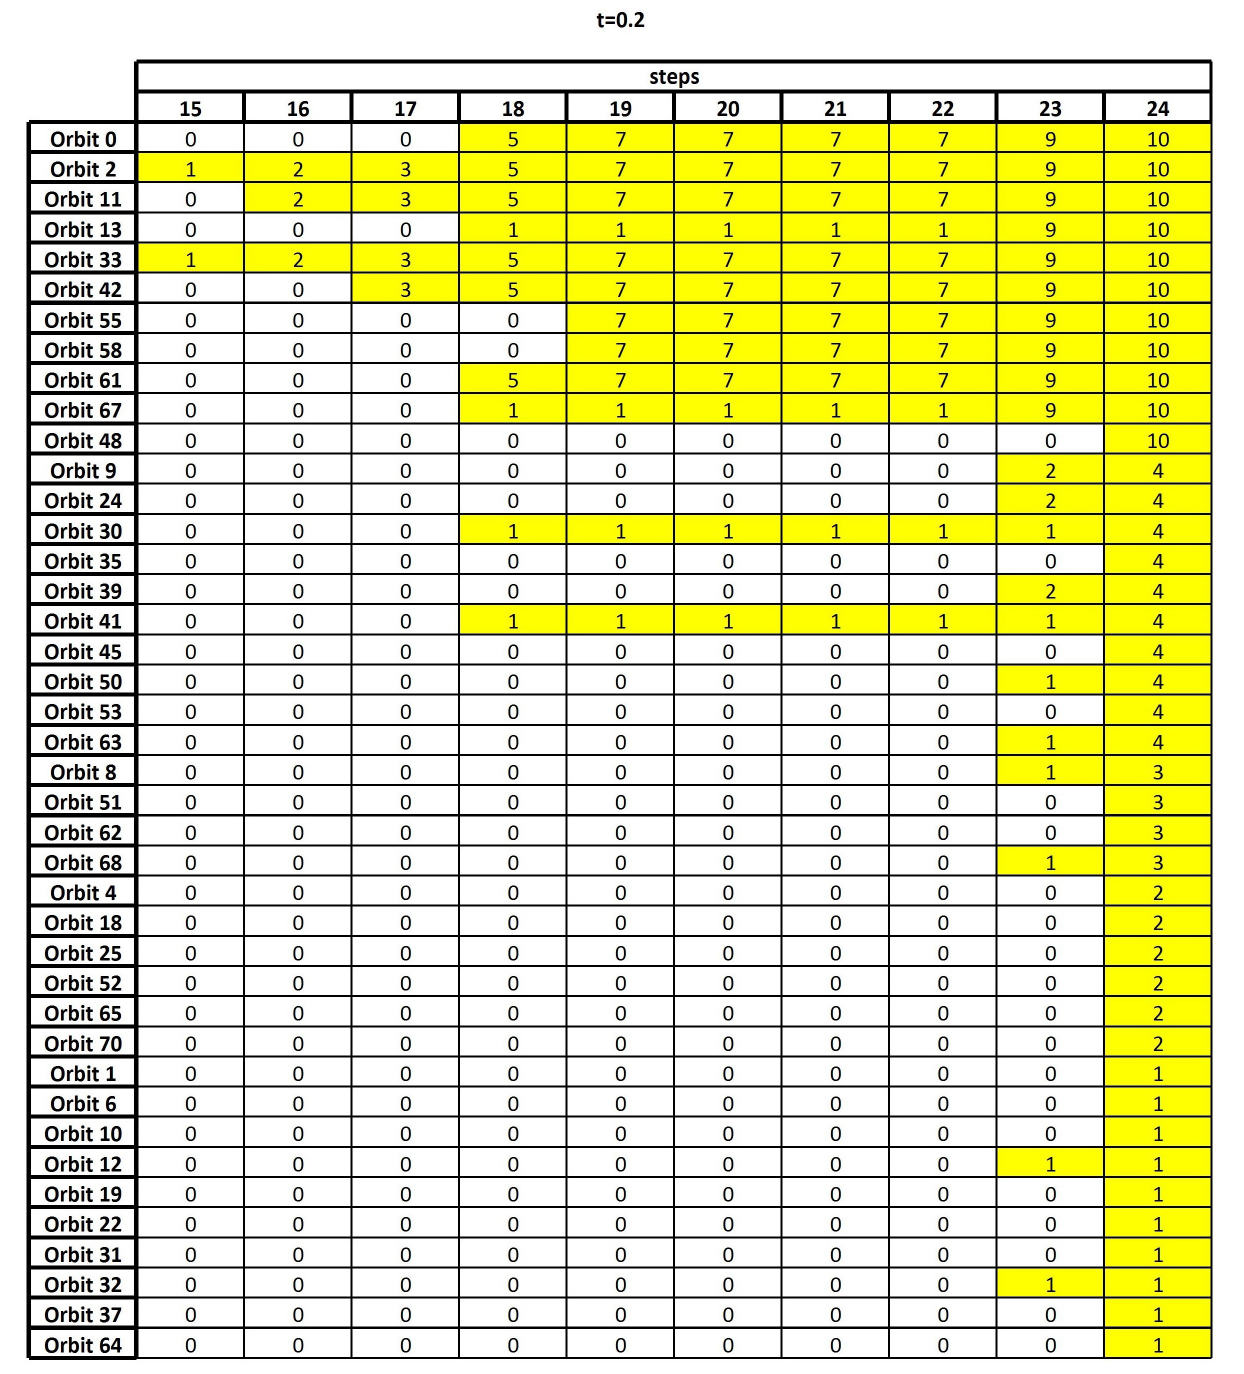
the 17-th step Orbit 42 also aggregates. At the 18-th step, Orbit 0 and Orbit 61 add to the previous list, thus forming a set S of 6 orbits whose corresponding columns of the sorted node table are equivalent on 24 − 18 + 1 = 7 nodes. At the same 18-th step, the four further 1’s indicate that the columns corresponding to